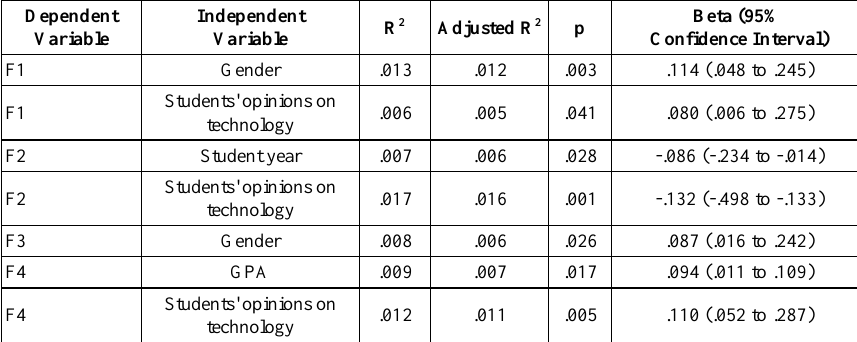
Table 5. Linear regression